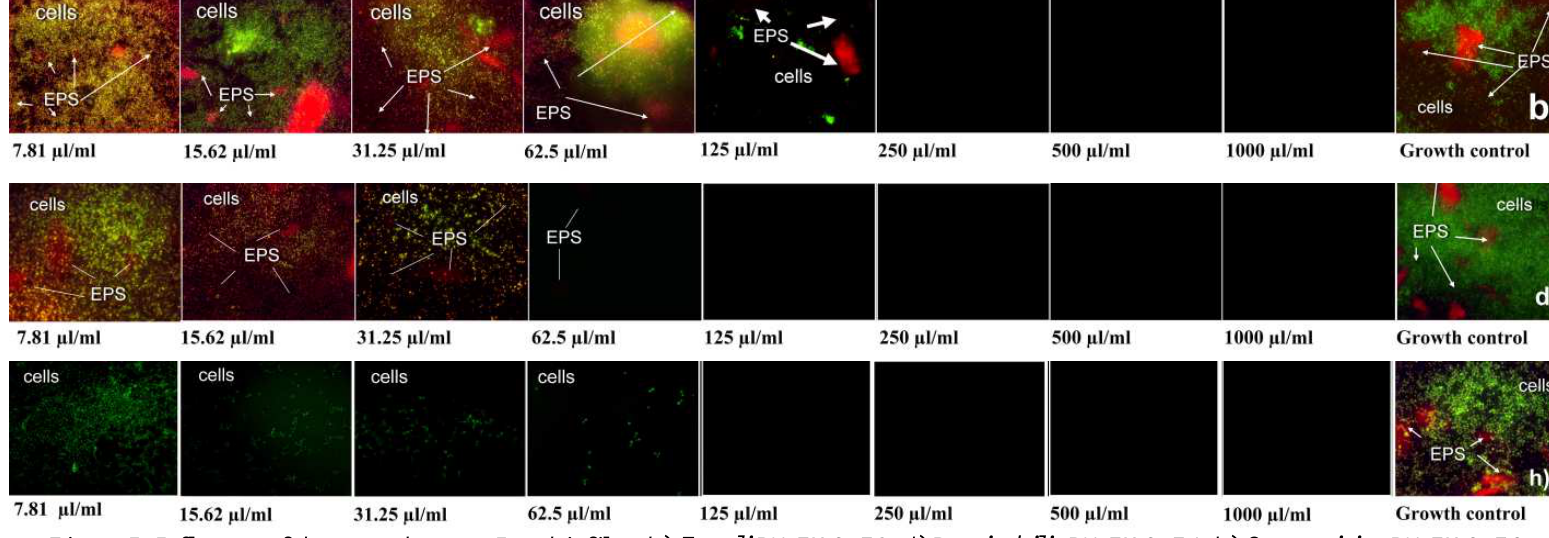
Figure 5. Influence of the test substance 5 on biofilms b) E. coli PMFKG-F2, d) P . mirabilis PMFKG-F4, h) S. cerevisiae PMFKG-F6. EPS – Extracellular polymer